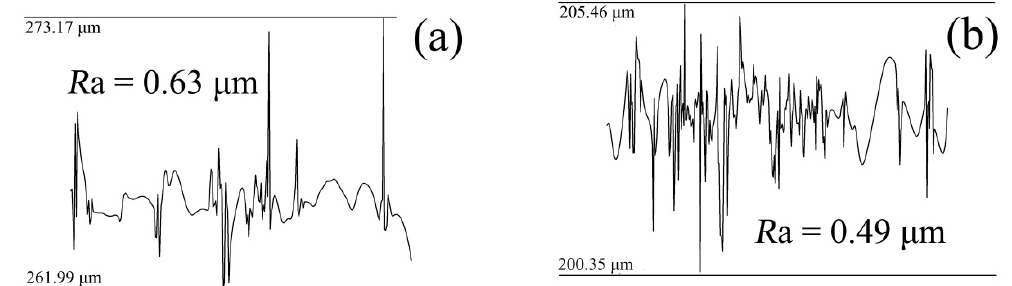
Figure 7. The roughness of the nickel mold. ( a ) Scheme 1; ( b ) scheme 2.